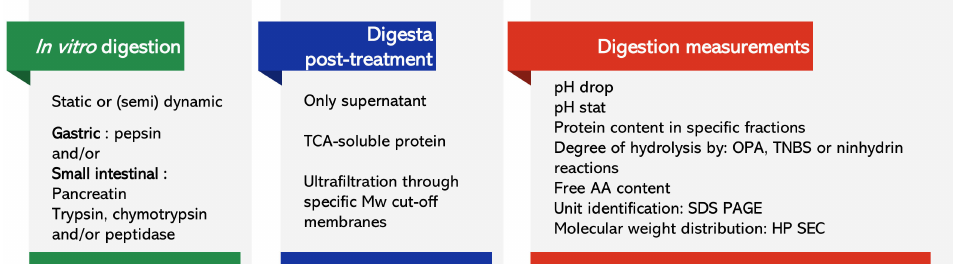
Figure 1. Characteristics of in vitro assays, treatment of digesta and description or quantification of digestibility in the studies reviewed. AA, amino acid; HP SEC, high performance size exclusion chromatography; Mw, molecular weight; OPA, o -phthalaldehyde; SDS PAGE, sodium dodecyl sulphate–polyacrylamide gel electrophoresis; TCA, trichloroacetic acid; TNBS, trinitro-benzene- sulfonic